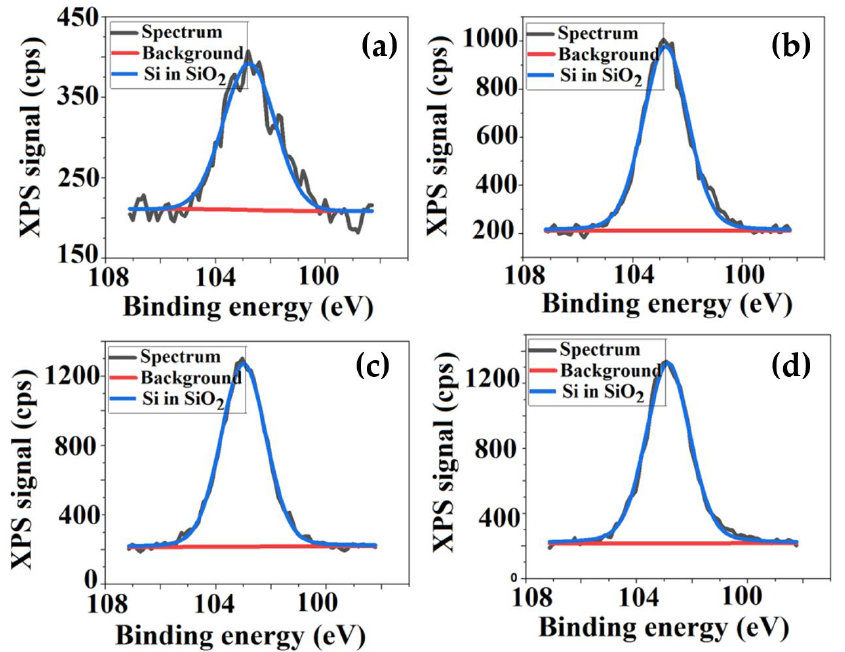
Figure 7. ( a ) CA+0.5 wt.% TEOS, Figure 7. The deconvolution of Si from SiO 2 spectra for: ( a ) CA+0.5 wt.% TEOS, ( b ) CA+1.0 wt.% ( b ) CA+1.0 wt.% TEOS, ( c ) CA+1.5 wt.% TEOS, ( d ) CA+2 wt.% TEOS TEOS, ( c ) CA+1.5 wt.% TEOS, ( d ) CA+2 wt.% TEOS films.